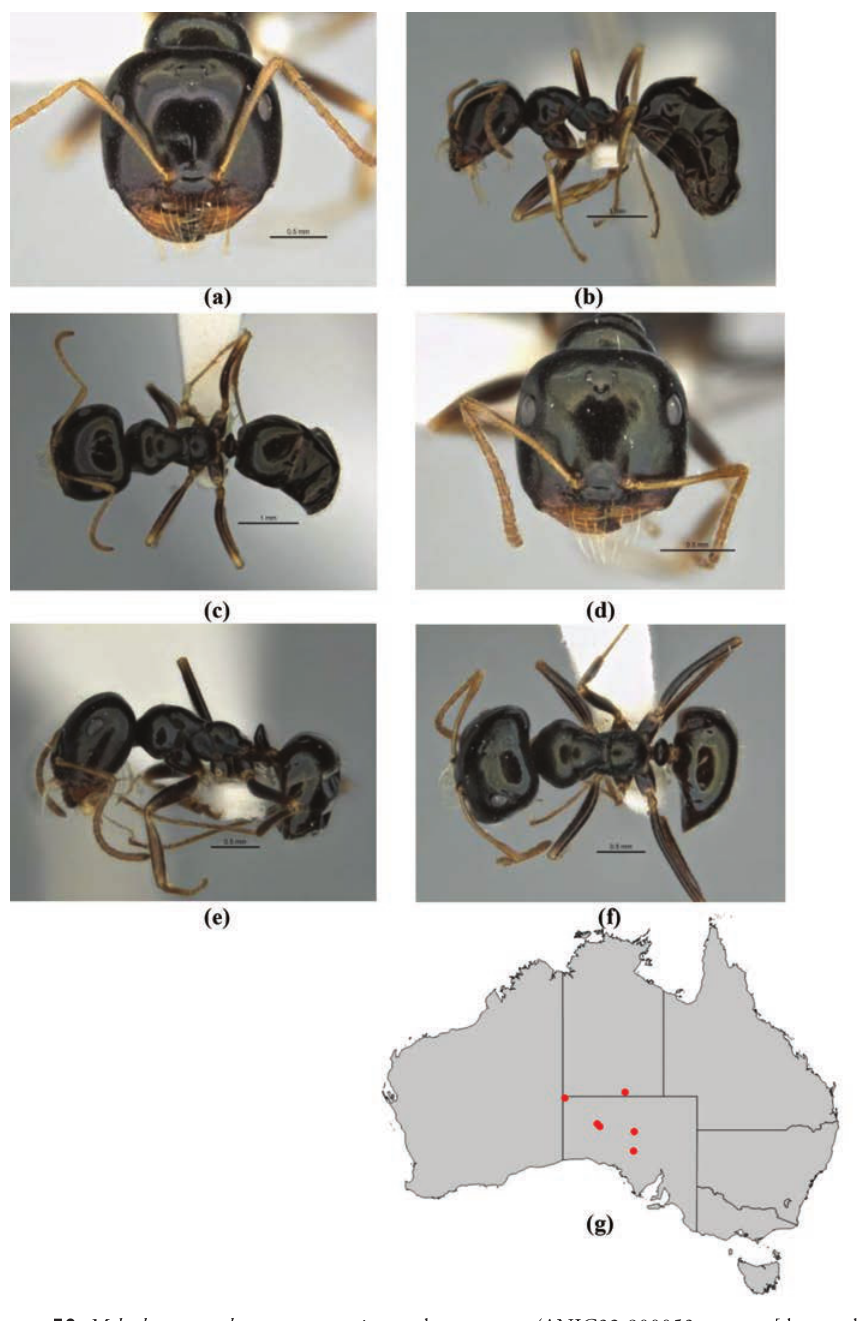
Figure 50. Melophorus quadratus sp. n.: major worker paratype (ANIC32-900053–top ant [damaged af- ter photograph taken]) frons ( a ), profile ( b ) and dorsum ( c ); minor worker holotype (ANIC32-900053– bottom ant) frons ( d ), profile ( e ) and dorsum ( f ); distribution map for the species ( g ). Low resolution scale bars: 1 mm ( b, c ); 0.5 mm ( a, d–f